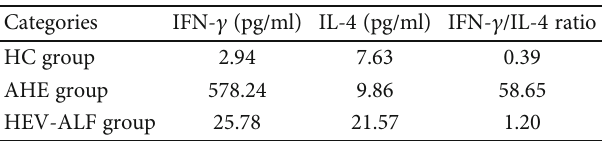
Table 2: Th1/Th2 (IFN- γ /IL4) ratios in the AHE group and HEV- ALF